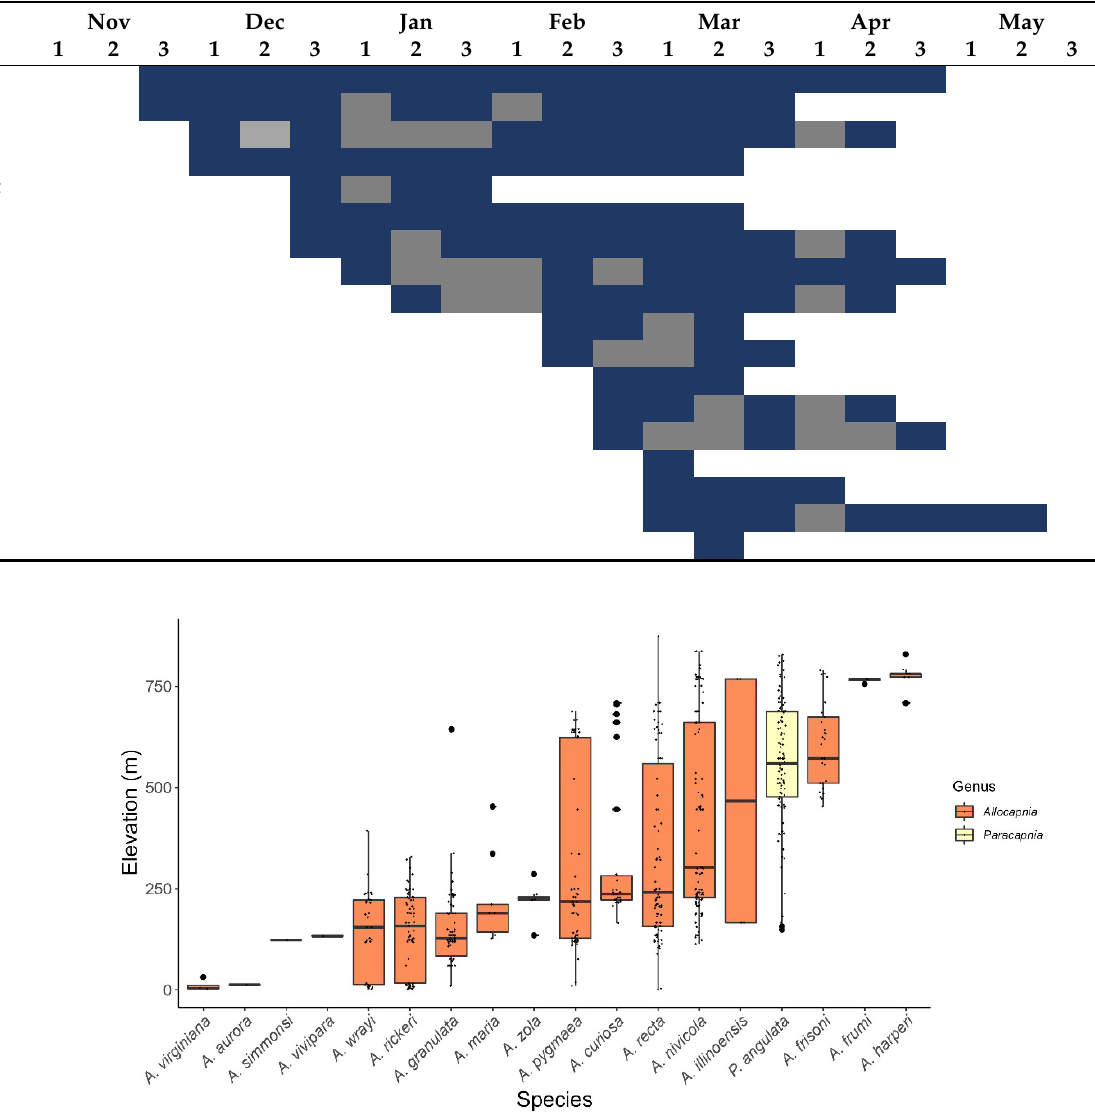
Figure 7. Elevation boxplots for Capniidae species recorded from Maryland. Boxes represent the interquartile range, while vertical lines extend to the minimum and maximum values. The horizontal line within the interquartile range represents the median elevation. Outliers are shown with large, solid circles. Small, individual points overlaid on each boxplot illustrate the distribution of observations. Table 4. Recorded adult Capniidae presence in Maryland. Months are broken into three 10-day periods. Dark blue squares represent periods with collections. Gray squares represent periods when species may be collected.